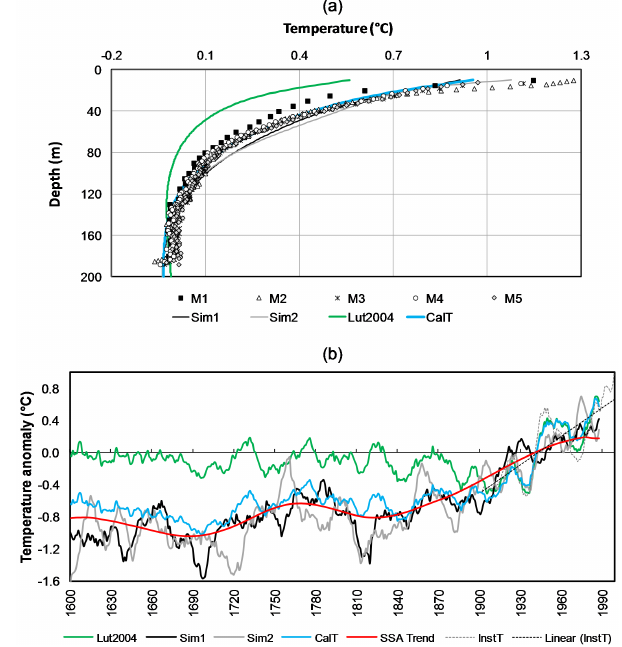
Figure 2. (a) Temperature–depth anomaly profiles for M1, M2, M3, M4 and M5, with respect to the estimated geothermal gradi- ents in Fig. 1b, along with the synthetic profiles generated from Lut2004 (reconstructed temperature), CalT (calibrated tempera- ture), and Sim1 and Sim2 (paleoclimate simulations) retrieved for a grid box near Lisbon, Portugal (cf. legends). (b) Chronograms of the 11-year running mean anomalies of Lut2004, CalT, and Sim1 and Sim2 for the period of 1600–1989. The SSA-filtered ensemble mean temperature from the two simulations (SSA trend) is also dis- played. The 11-year running means of InstT (instrumental annual mean temperature) anomalies are depicted for the period of 1901– 1999, along with the respective linear trend. Note that anomalies in each series are with respect to their common period